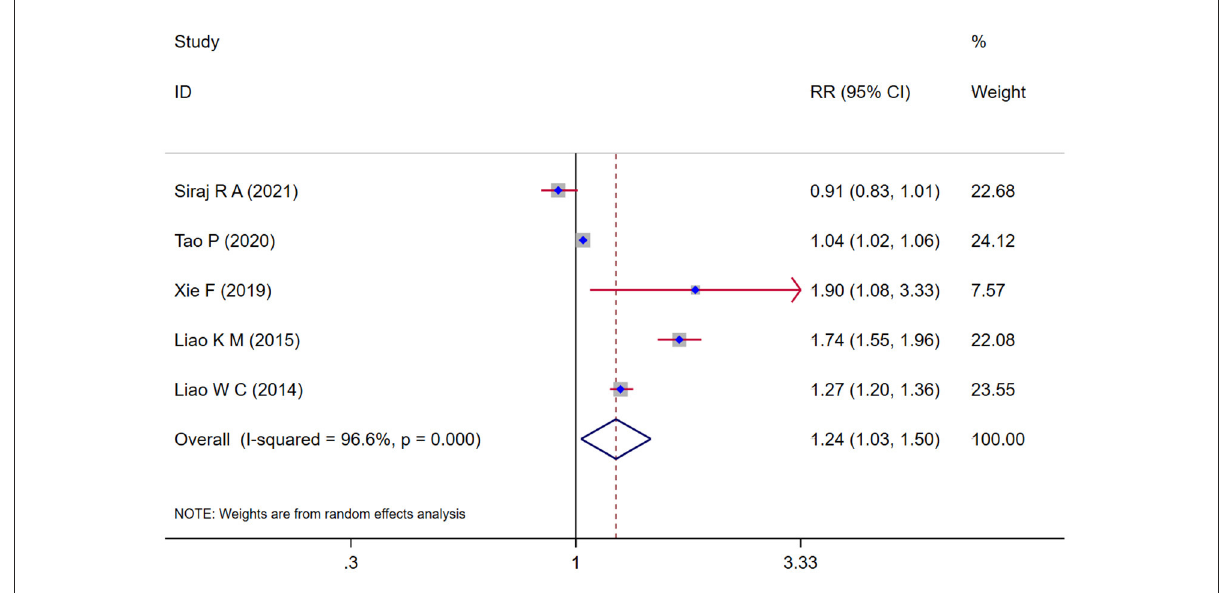
FIGURE2 Forest plot showing the effect of COPD on dementia.